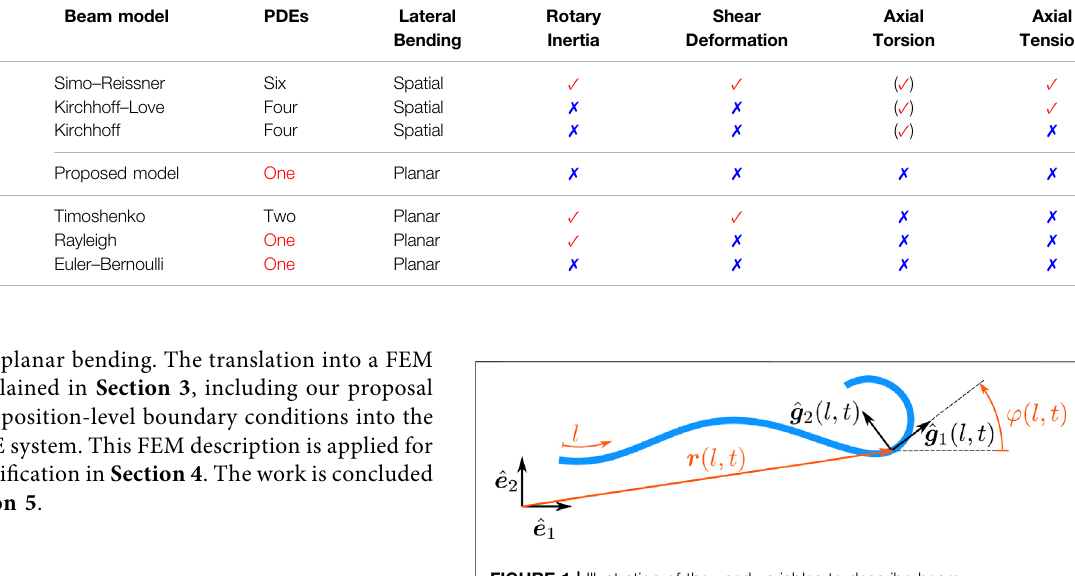
FIGURE 1 | Illustration of the used variables to describe beam